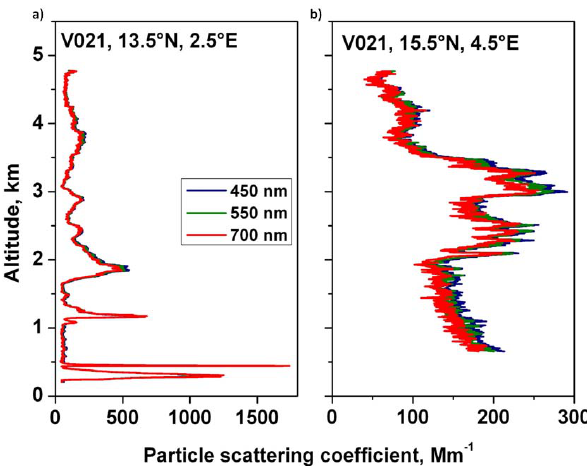
Fig. 15. Vertical profiles of the aerosol scattering coefficient of min- eral dust as measured during flight V021 of SOP 1a1 at 450 (blue line), 550 (green line), and 700nm (red line) by the